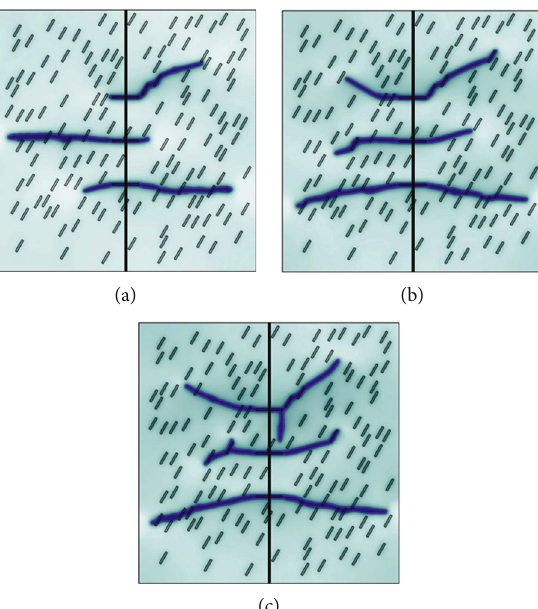
Figure 19: Fracture network morphology for varying fl uid viscosities. (a) μ = 1MPa · s , (b) μ = 5 MPa · s , and (c) μ = 10MPa · s